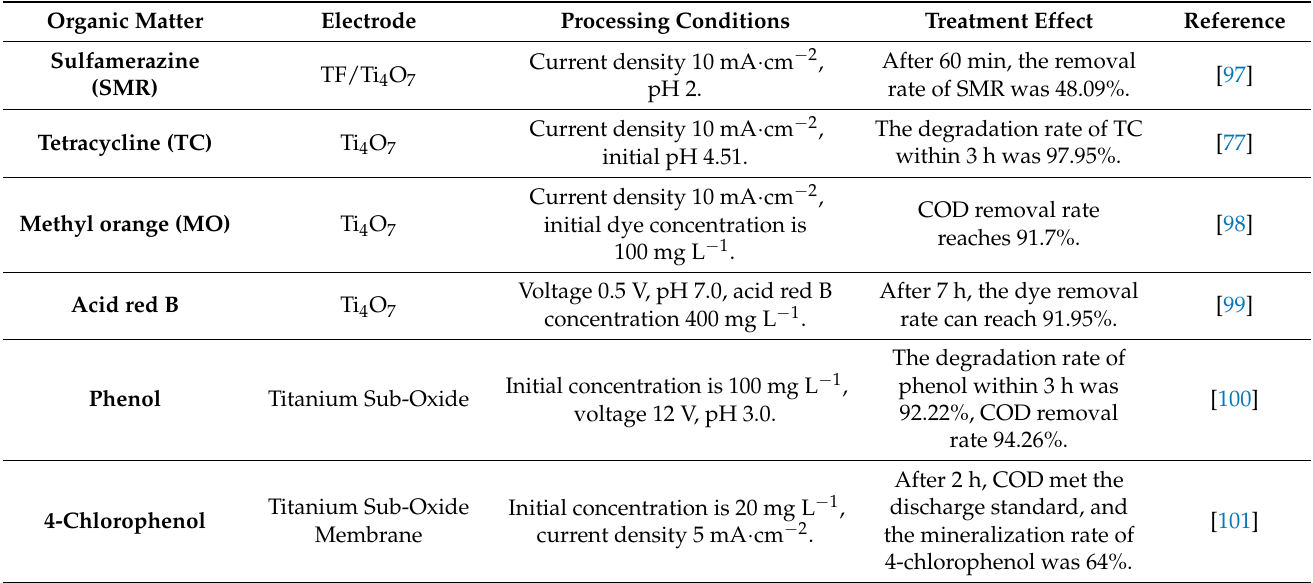
Table 5. Titanium sub-oxides as electrode electro-oxidation to degrade organic